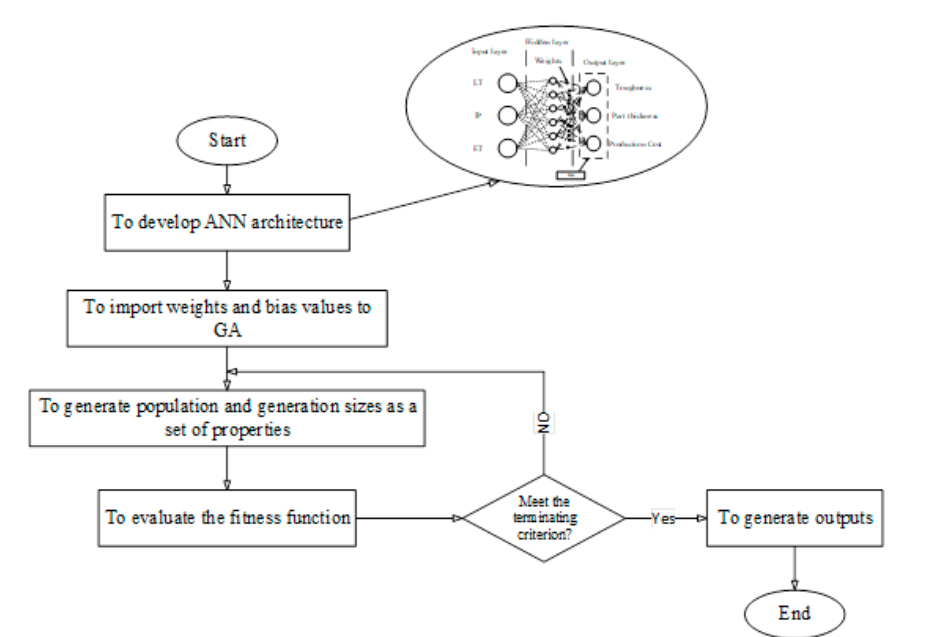
Figure 2. The flowchart of the artificial neural network-genetic algorithm (ANN-GA)-developing process.